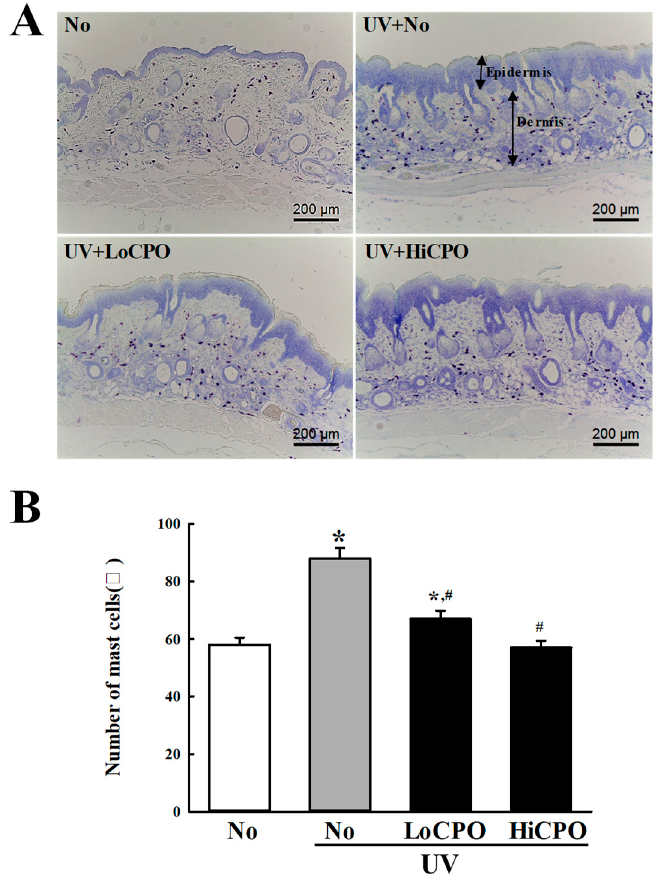
Figure 10. Number of mast cells into photoaging skin. Numbers of mast cells in skin tissue sections were determined by toluidine blue staining at 400 × magnification. Total cells numbers in 1 mm 2 were counted at three di ff erent sites per section. Three to five mice per group were used and mast cell numbers were determined in duplicate. Data are reported as the means ± SD. * p < 0.05 compared to the No group. # p < 0.05 compared to the UV + No group. Abbreviations: LoCPO, low amount CPO; HiCPO, high amount